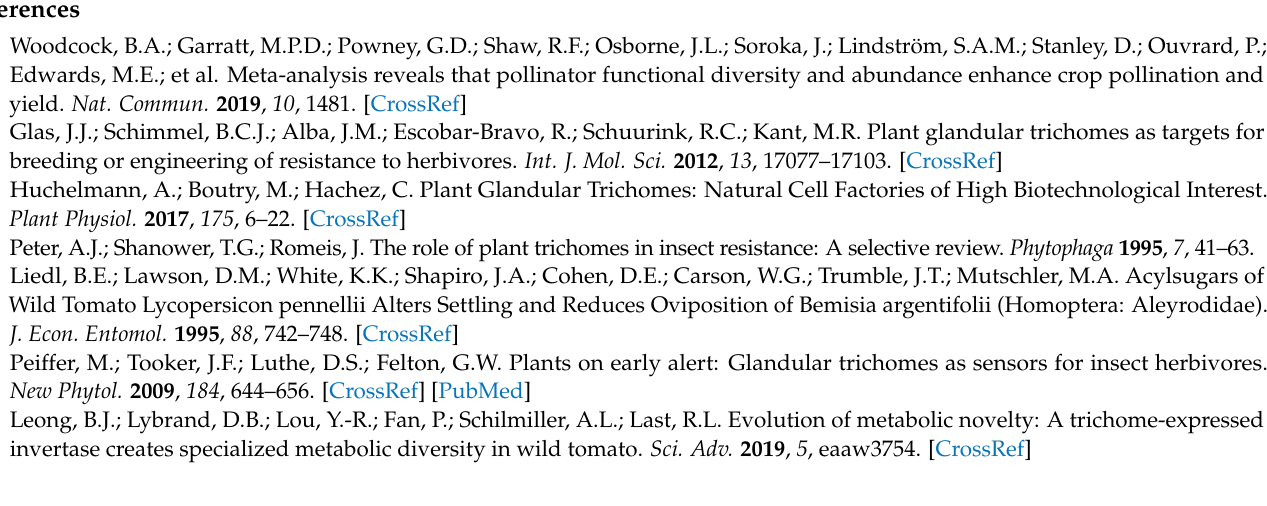
when available is also provided, Supplementary Figure S1. Graphical summary of the experimental design for the evaluation of plant age and leaf age. (A) First and second fully expanded leaves from the apex of the plant. (B) Location of second leaflet of a second fully expanded leaf. (C) Excision of the leaflet perpendicularly to the central vein. Trichome density was estimated in four random areas in the abaxial region, Supplementary Figure S2. Density of type IV trichomes in the matting populations along the three weeks of phenotyping for the SLC family (BGV016047 × LA2278) (A) and SLL family (BGV016047 × MoneyMaker) (B), Supplementary Figure S3. Read number by sample, Supplementary Figure S4. Bases sequenced at 5 × and 20 × coverages by sample, Supplementary Figure S5. Genotyped SNPs by sample, Supplementary Figure S6 Genetic map of the F2 population of the SLC family based on 8,285 bin markers, Supplementary Figure S7. Results of the association analysis of the trichome IV density along the genome (A) 6th week after transplanting, (B) 7th week and (C) 8th weeks. The minus logarithm of corrected p -values obtained after fitting to a negative binomial logistic regression model are shown. Horizontal dashed line represents the p -value threshold of 0.01, Supplementary File 1. K-seq primer sequences, Supplementary File 2. Data recorded during trichome density measures. Mean: mean of trichome density from 4 measures per leaf, leafA: first measure, leafB: second measure, leafC: third measure, position: the position of